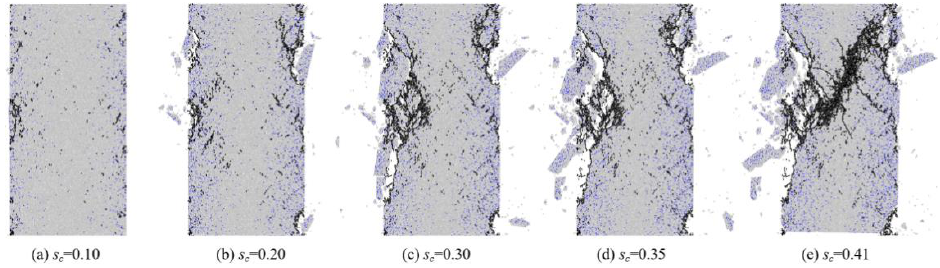
Figure 13. Failure evolution of specimen in Case 5, k s = 0.8.